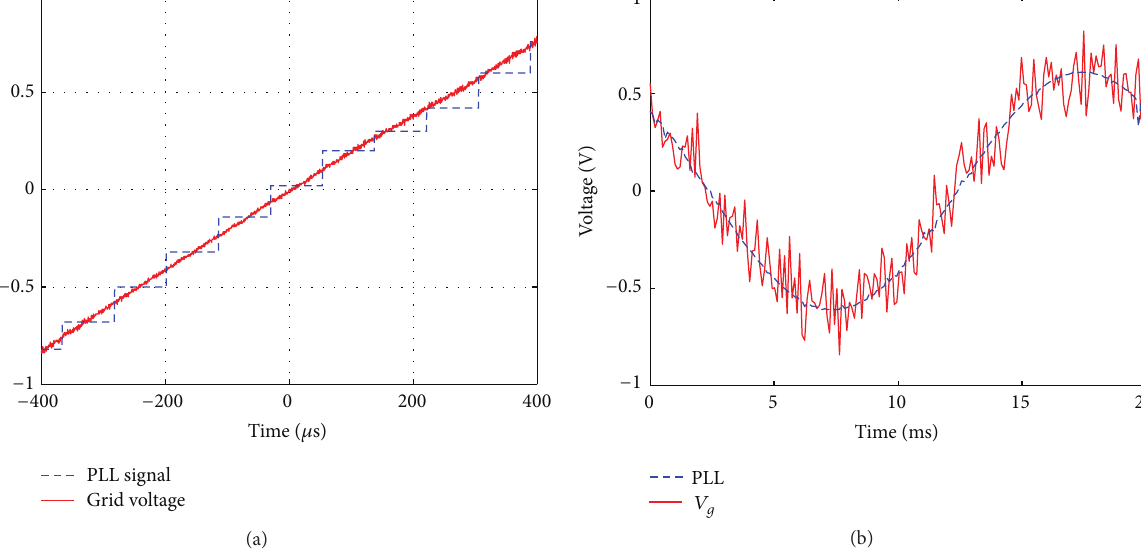
Figure 10: Time domain phase tracking of the grid voltage. In (a), the discrete steps of the PLL output are shown, based on a sampling time of 84 𝜇 s, around the zero-crossing of the grid voltage. In (b), 20% Gaussian noise is added to the grid voltage, and the resultant PLL output acts as a lowpass